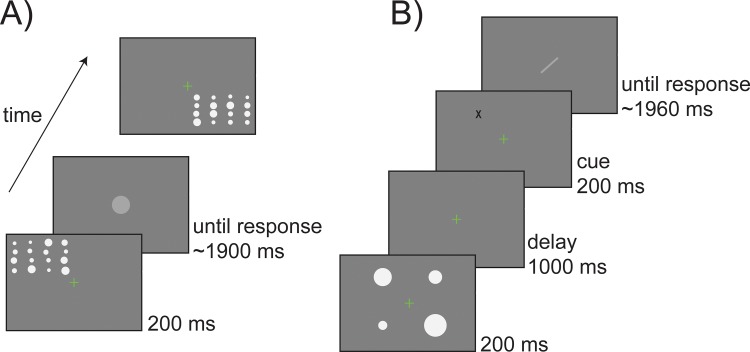
(A) Example of one trial in the ensemble coding task of Experiment 7. Participants viewed an ensemble of 16 dots in one of the four quadrants and had to report the average size by adjusting the size of a response dot. (B) Example of one trial with four items in the working memory task of Experiment 8. Participants had to memorize the size of each dot and reproduce the diameter of the dot indicated by a retro-cue (black X). The diameter was reported by adjusting the length of a central bar, which was randomly oriented on each trial.